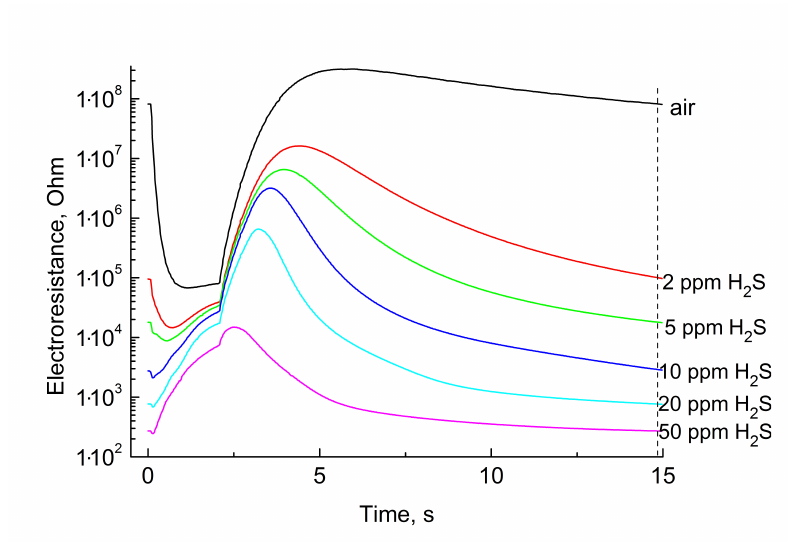
Figure 6. Electrical resistance of the sensor as a function of time during one measurement cycle at determining different H 2 S